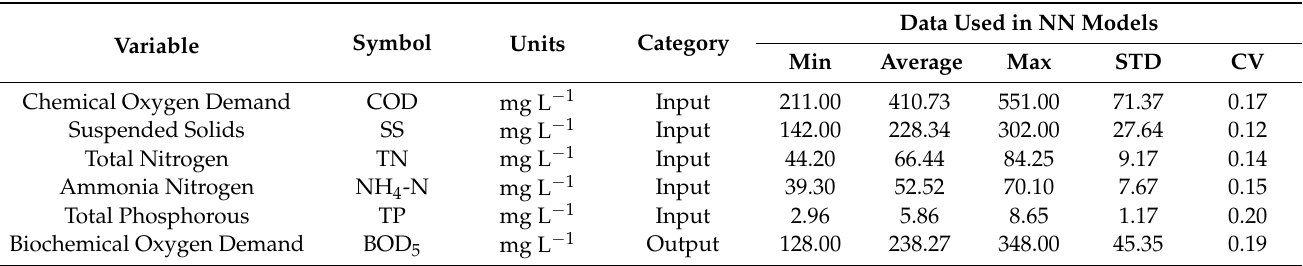
Table 3. Statistical analysis of the input and output parameters used in this research for the training and development of artificial neural